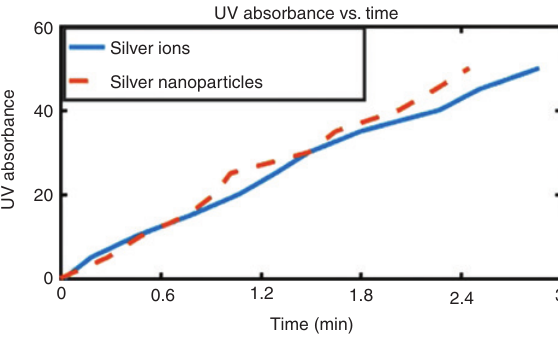
Figure 11: Ag + and Ag nanoparticle UV-Vis